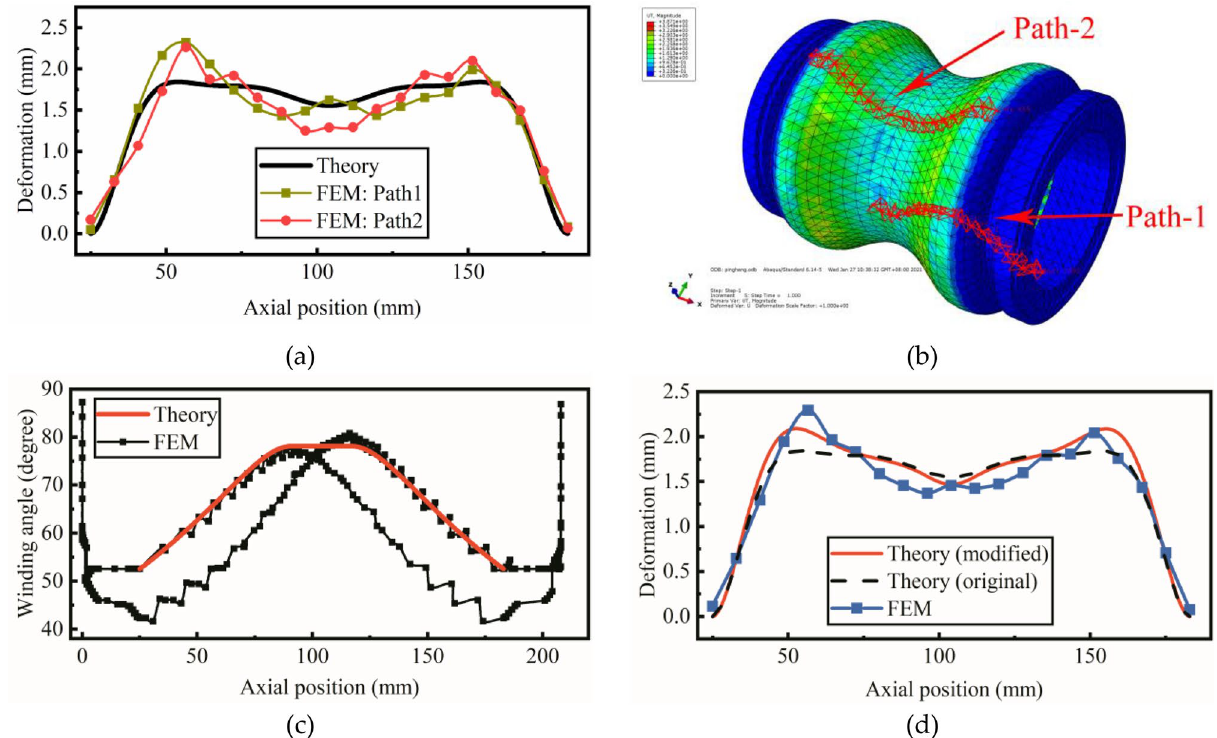
Figure 9. ( a ) The comparison of the deformation between the theoretical model and the finite element model. ( b ) The position of Path-1 and Path-2 on the finite element model. The figure was created with ABAQUS 6.14. URL: https ://www.3ds.com/produ cts-servi ces/simul ia/produ cts/abaqu s/ ( c ) The comparison of optimal winding angle between the theoretical model and the finite element model. ( d ) The comparison of the